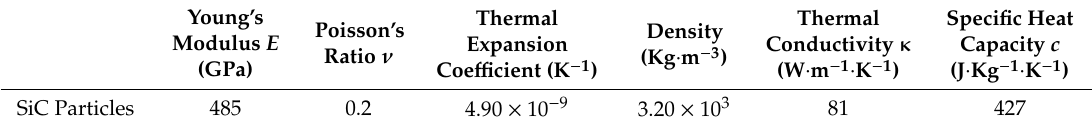
Table 3. SiC particle material